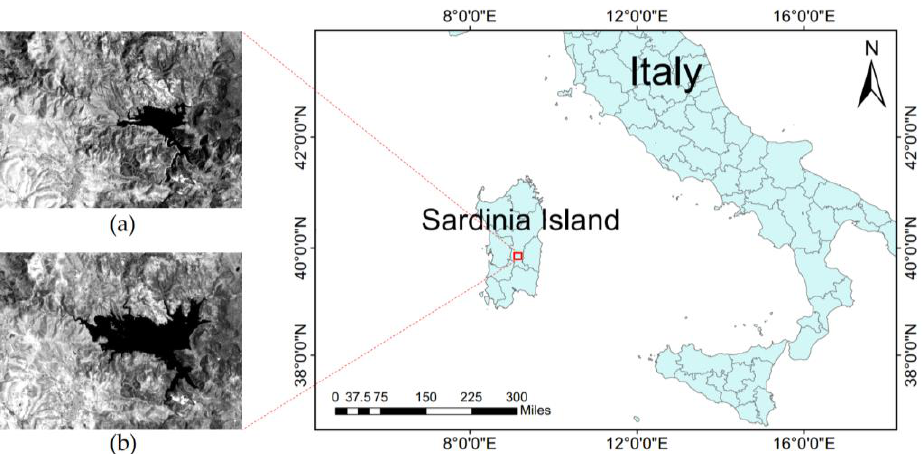
Figure 5. Sardinia island dataset. ( a ) Image acquired in September 1995. ( b ) Image acquired in July 1996.